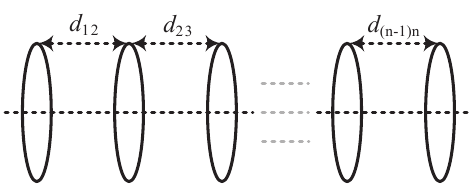
Figure 6. General model of domino-system with n